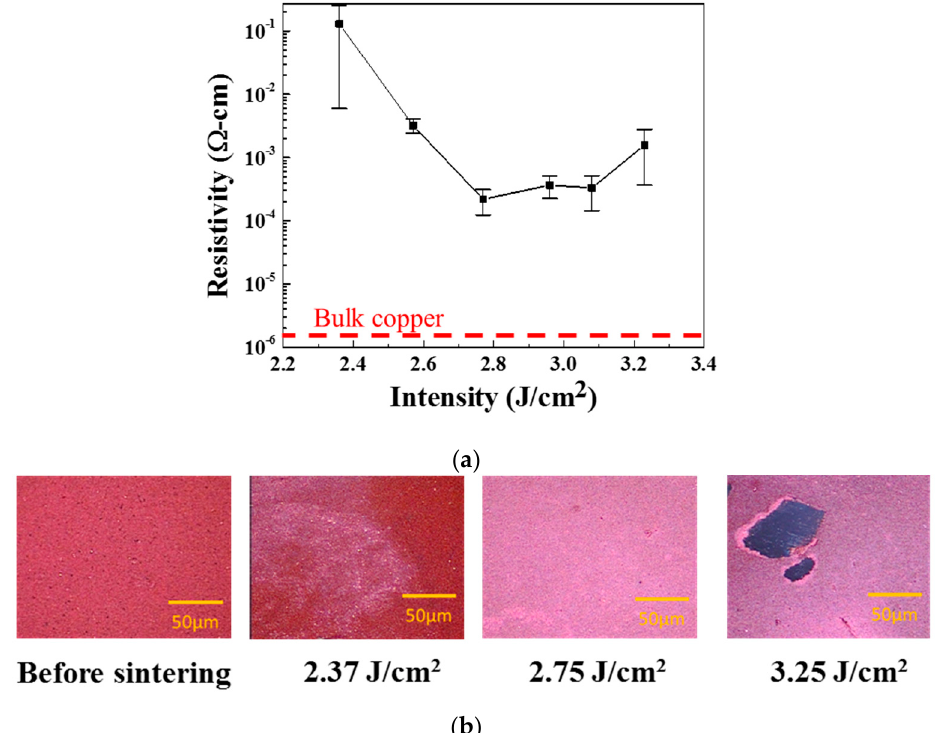
Figure 3. ( a ) Variation in resistivity of sintered copper films with single pulse energy intensity. ( b ) Optical images of copper film before and after sintering with various IPL energy intensities. The picture at 3.25 J/cm 2 shows an example of a crack.